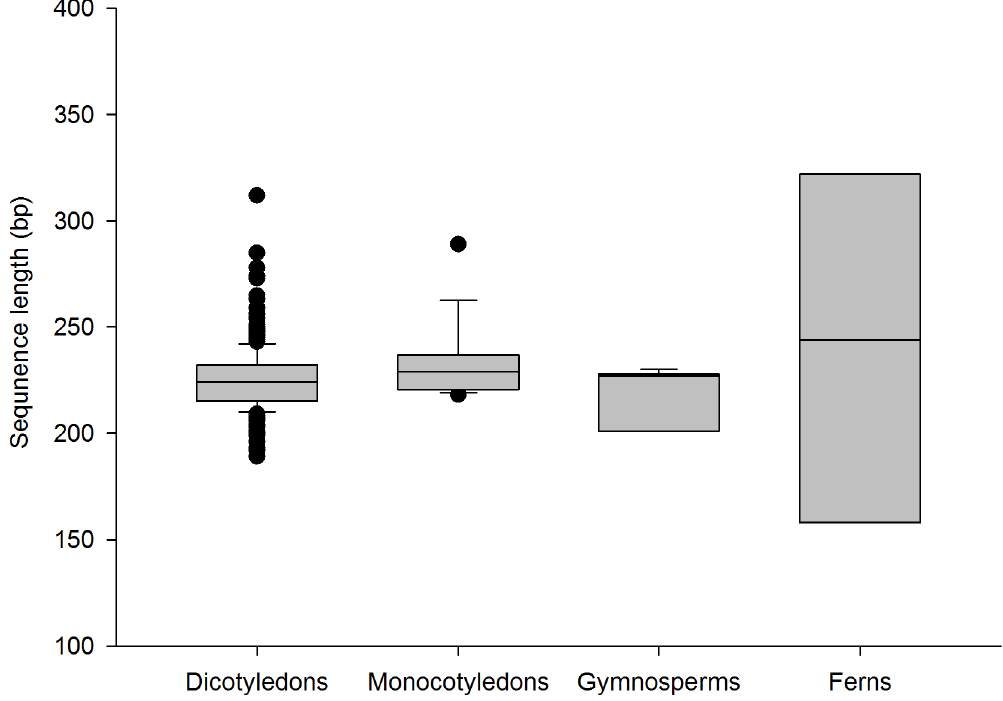
Fig 2. Box plots of the ITS2 barcodes length of southern herbs. The box plot illustrates the interquartile range (IQR) of the data. The IQR is defined as the difference between the 75th percentile and the 25th percentile. The line through the box represents the median